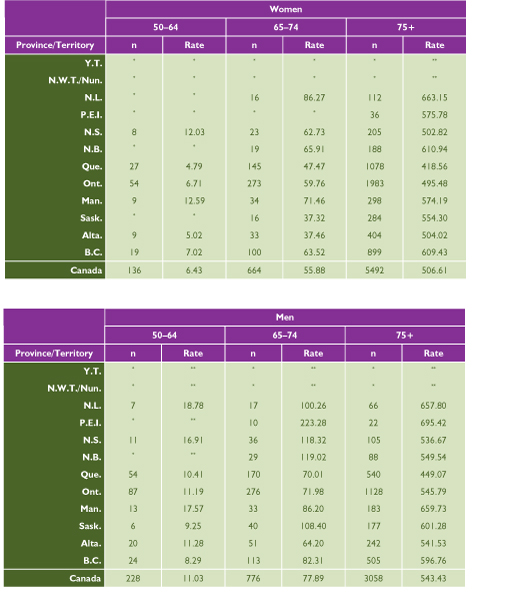
Age and Sex-Specific Cerebral Infarction Mortality Rates per 100,000 in Canada by Province and Territory, 1997–1998 Source: Health Canada, Canadian Mortality Database